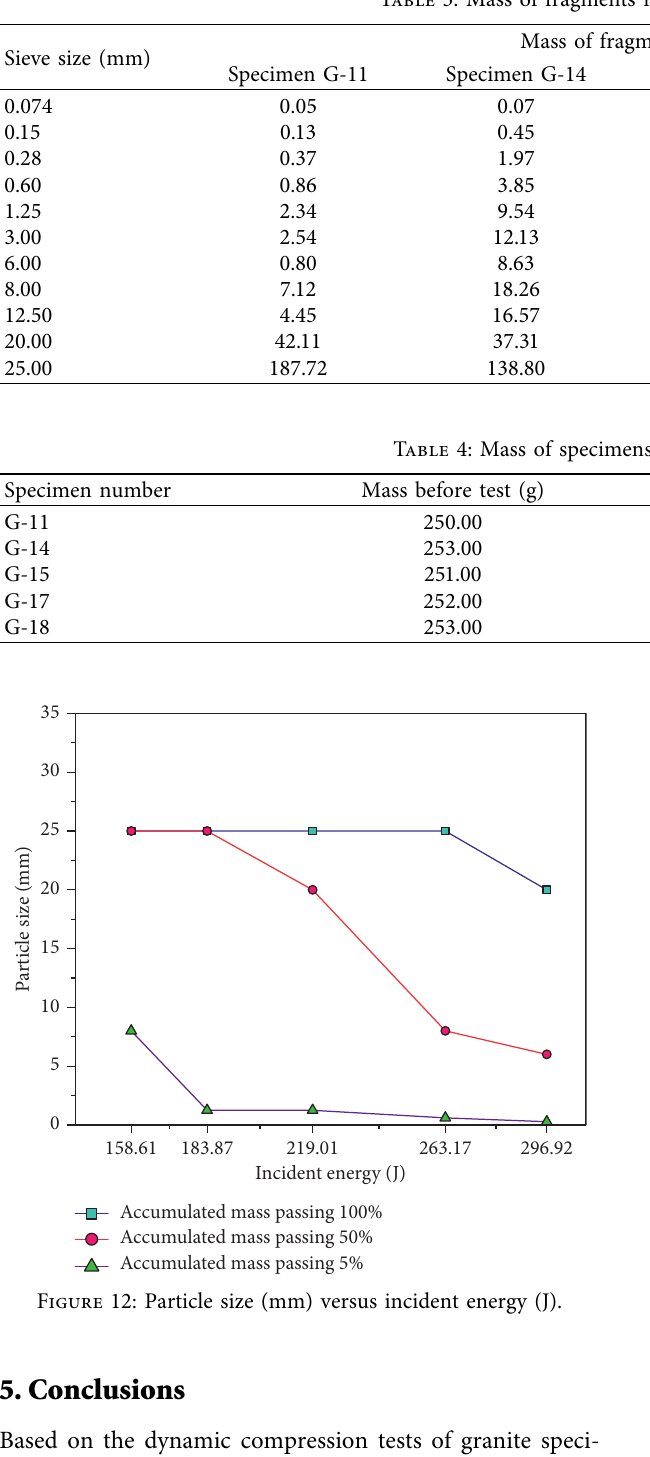
Table 3: Mass of fragments remained on each sieve.